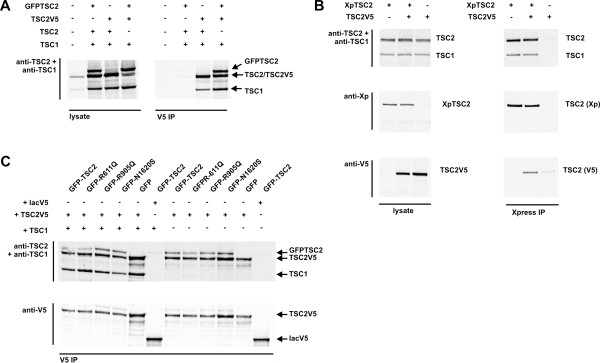
Coimmunoprecipitation of distinct epitope-tagged TSC2 isoforms. Untagged TSC2, GFPTSC2, XpTSC2 and/or TSC2V5 were co-expressed in HEK293T cells with or without co-expressed TSC1. Distinct tagged isoforms were immunoprecipitated and the presence of other coimmunoprecipitated tagged isoforms was investigated by immunoblotting. (A) Coimmunoprecipitation of TSC1 and GFPTSC2 with TSC2V5. TSC2V5 was co-expressed with GFPTSC2 or untagged TSC2. GFPTSC2 was detectable as a 220 kDa band in immunoblots of the cell lysates, distinct from the 200 kDa TSC2 and TSC2V5 bands. TSC2V5 was immunoprecipitated from the lysates with V5 affinity beads. Immunoblotting of the washed beads showed that GFPTSC2 was coimmunoprecipitated with TSC2V5. No GFPTSC2 was immunoprecipitated in the absence of TSC2V5. (B) Coimmunoprecipitation of TSC1 and TSC2V5 with XpTSC2. XpTSC2 was immunoprecipitated from cell lysates with an antibody specific for the Xpress tag. The Xpress- and V5-tagged TSC2 isoforms could be distinguished by immunoblotting using the appropriate specific antibodies. TSC2V5 coimmunoprecipitated with XpTSC2. (C) Coimmunoprecipitation of GFPTSC2 variants with TSC2V5. TSC2V5 was co-expressed with GFPTSC2 or GFPTSC2 containing the R611Q (GFPR611Q), R905Q (GFPR905Q) or N1620S (GFPN1620S) pathogenic substitutions, with or without co-expressed TSC1. As a control, GFPTSC2 was co-expressed with V5-tagged B-lactamase (lacV5). All the GFP-tagged TSC2 variants were coimmunoprecipitated with TSC2V5. In contrast, GFPTSC2 was not detected in the lacV5 immunoprecipitates.